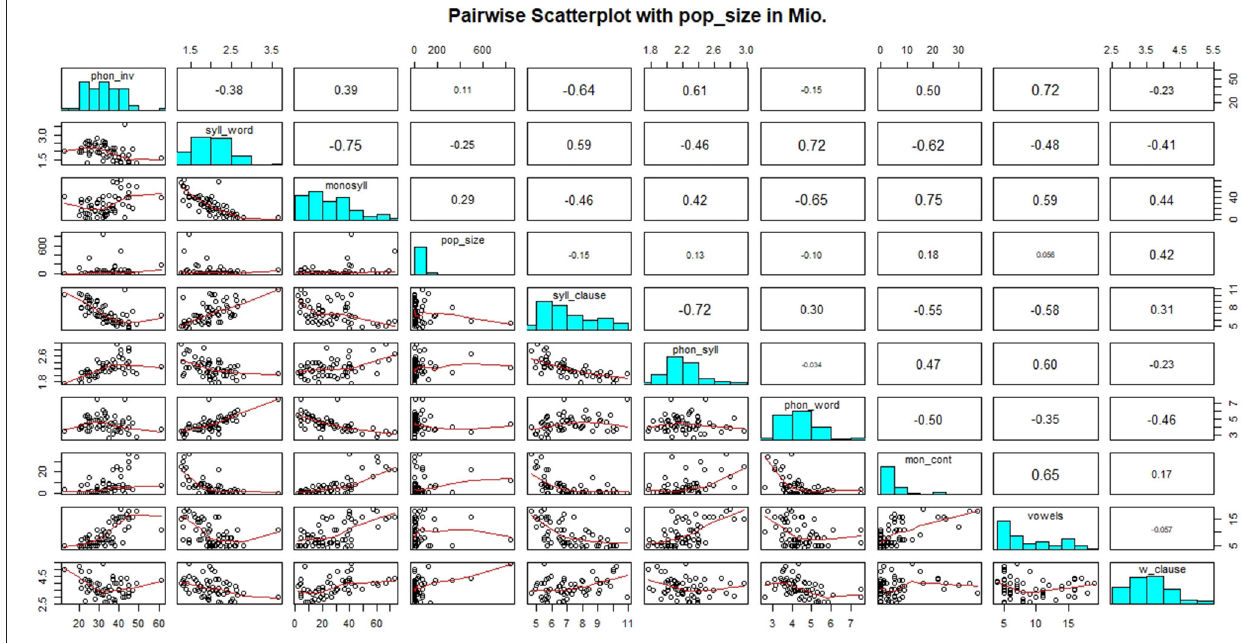
FIGURE 1 | Pairwise scatterplot with population